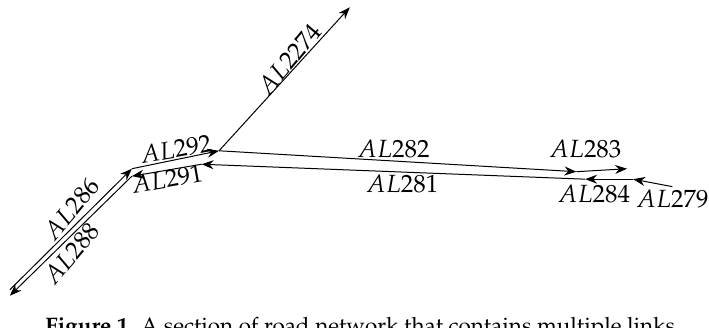
Figure 1. A section of road network that contains multiple